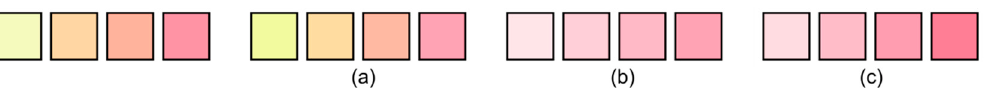
Figure 7. The OpenStreetMap road network color scheme. Figure 8. The OpenStreetMap road network symbols color scheme (left) and suggestions: ( a ) for analogous color scheme; ( b ) and ( c ) alternatives for monochromatic color schemes.